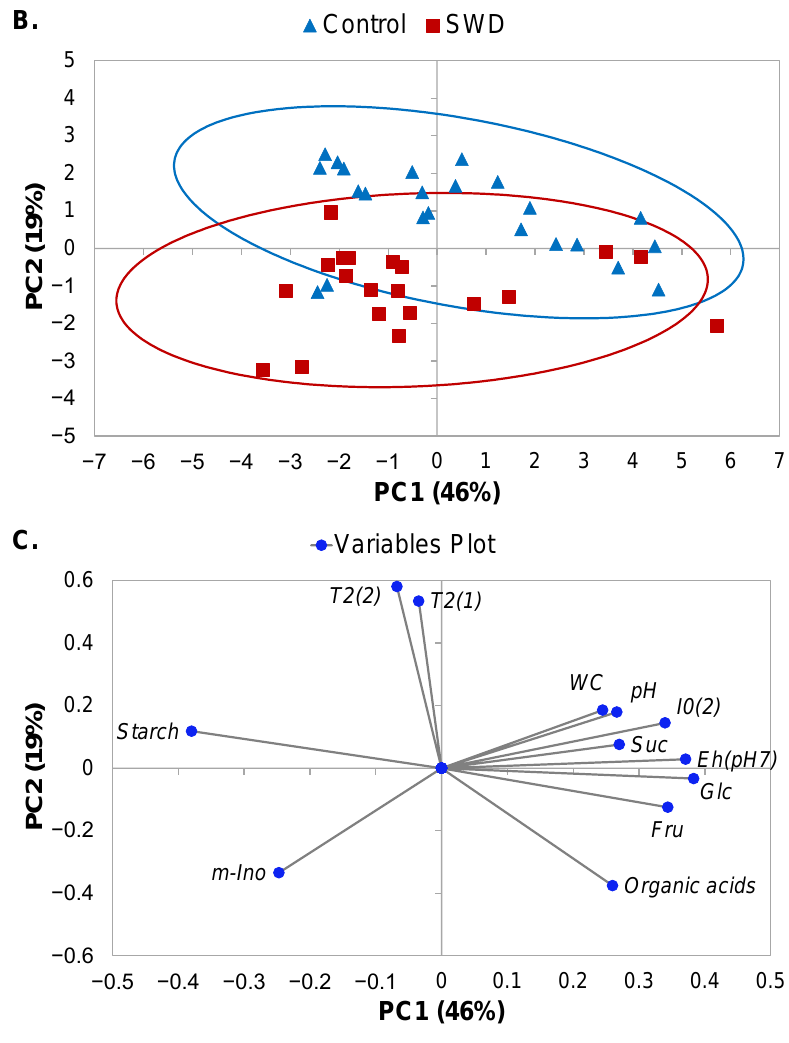
Figure 6. Principal component analysis (PCA) score plots ( A , B ) and loading plot for variables ( C ) derived from data obtained from MRI relaxometry and physiological measurements of potato tuber tissues using principal components 1 (PC1) and 2 (PC2). Observations shown on the score plots are differentiated by colour and symbol to indicate sample classification according to ( A ) growth period and ( B ) water regime. Continuous lines on score plots ( A , B ) represent the ellipsis of confidence at 95% confidence for each group.